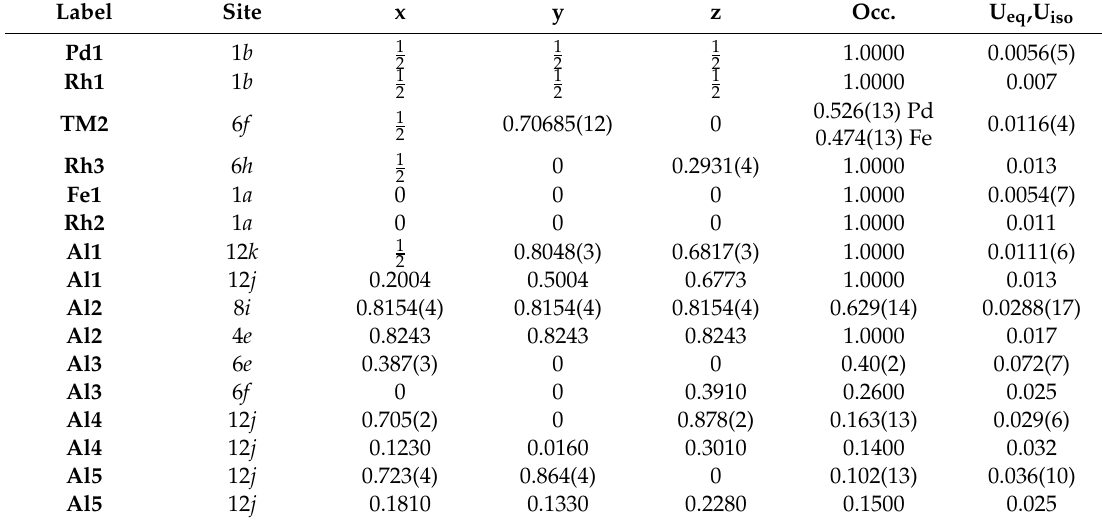
Table 3. The atomic positions of the C (cid:48) -phase (in gray) compared to those of the Al 2.63 Rh phase (Occ. indicates the site occupancy